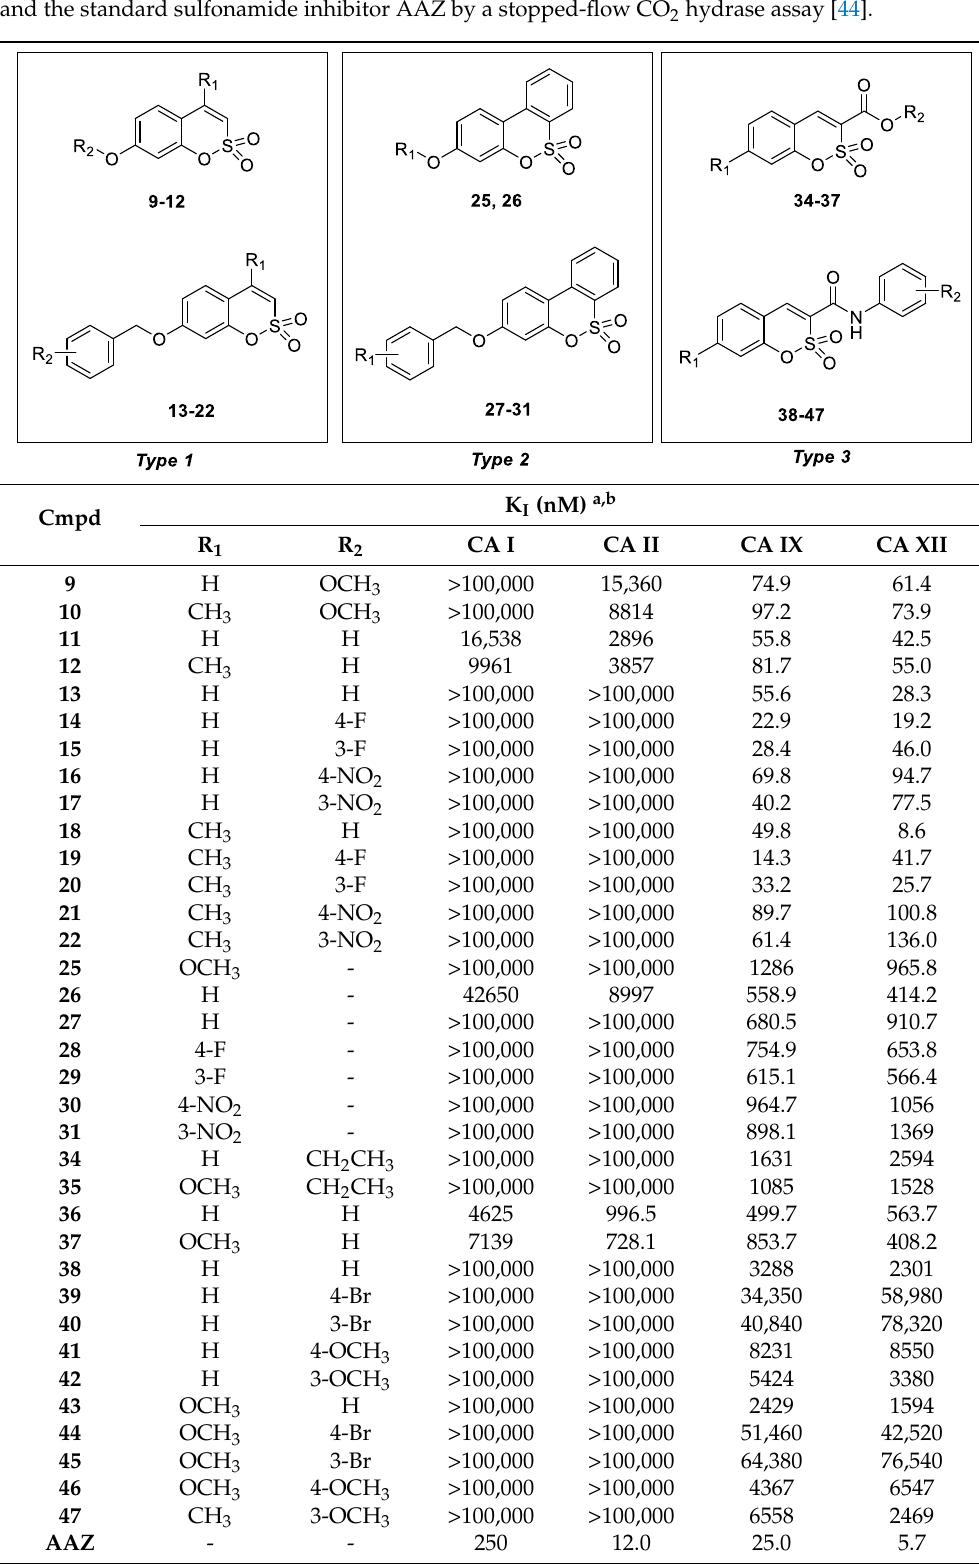
Table 1. Inhibition data of hCA isoforms I, II, IX and XII with sulfocoumarins 13 – 22 , 27 – 31 , 38 – 47